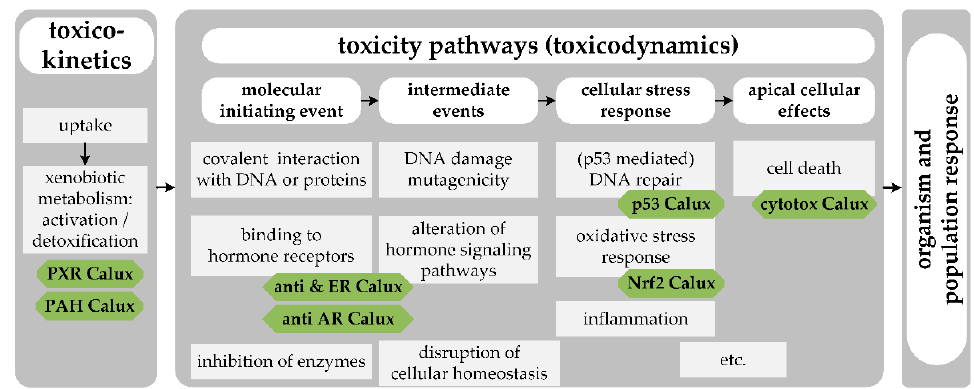
Figure 2. In vitro CALUX bioassay panel allocated to the corresponding events on the toxicity pathway ( according to [ 14], modified) .